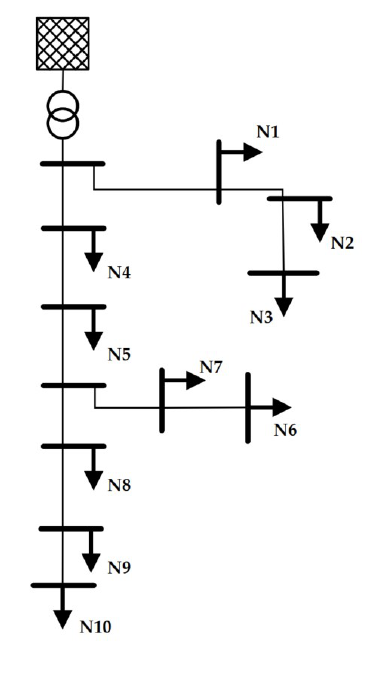
Figure 2. Scheme of reference grid number 8 from [45] with labeled grid